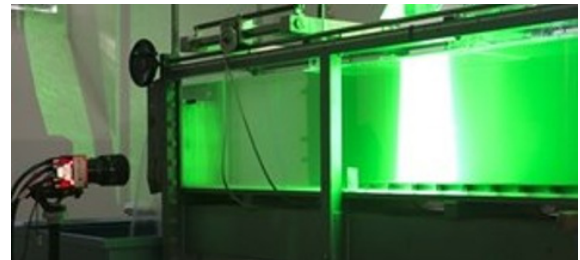
Fig. 6. Experimental